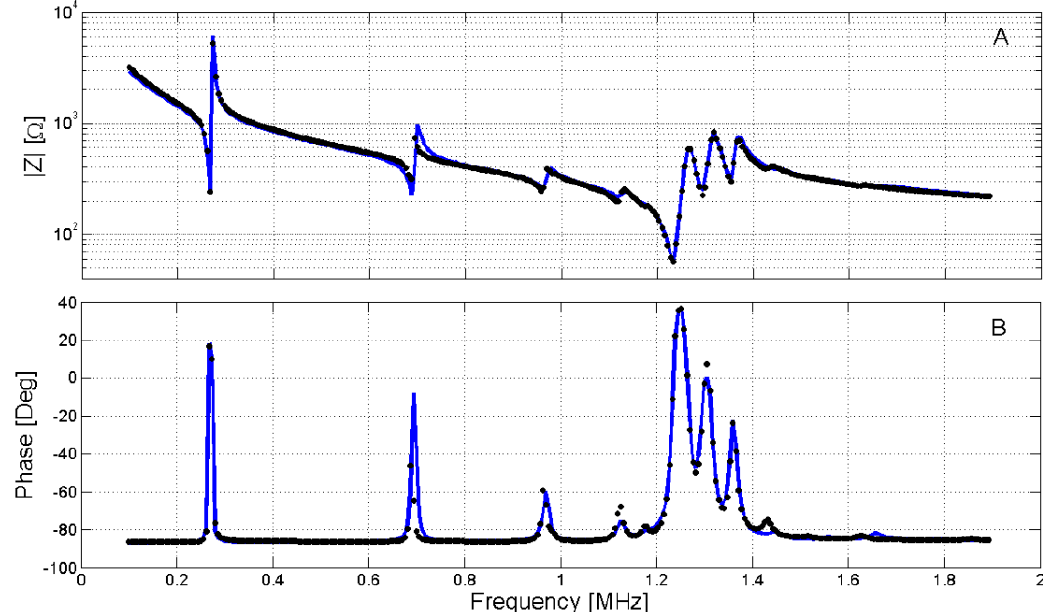
Figure 5. Result of the minimization of the numerical calculation (black dots) and experimental spectrum (continuous blue line) at 100 °C. ( A ) Modulus of the complex electric impedance; ( B ) Phase of the impedance.